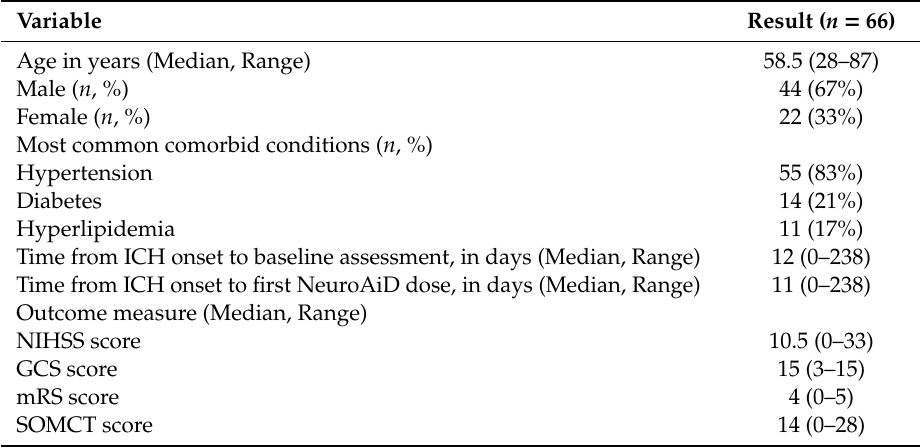
Table 1. Baseline